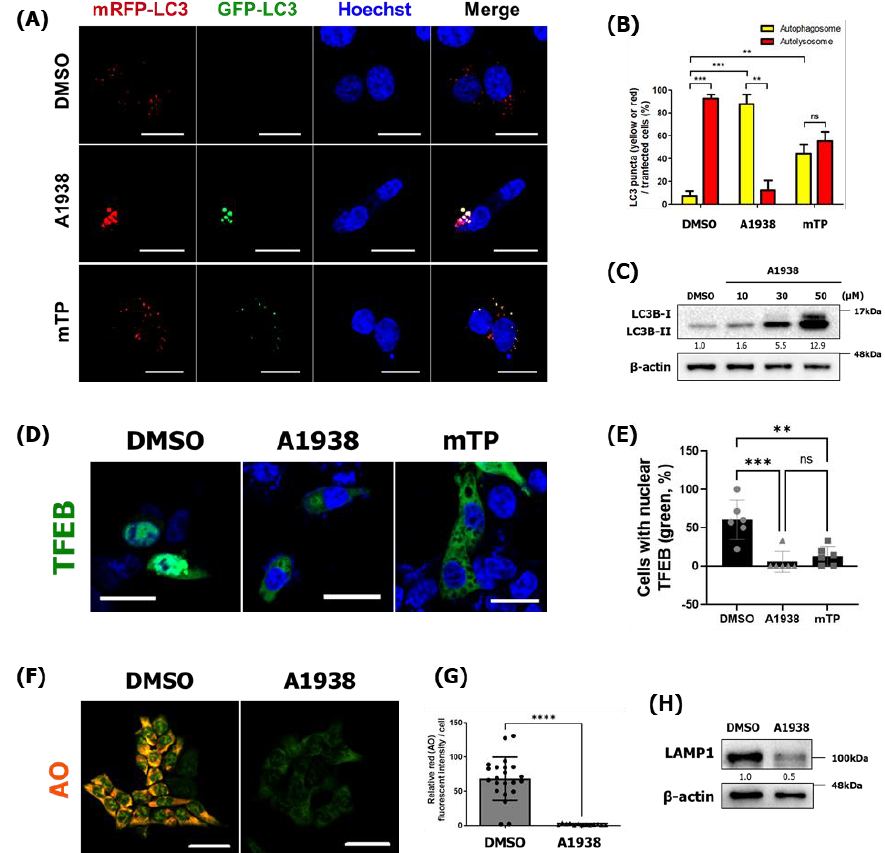
Figure 6. A1938 impairs autophagy through the downregulation of mROS in HCT116 cells ( A ) Confocal microscopy image of HCT116 cells transfected with mRFP-GFP-LC3 and treated with DMSO, A1938, or mTP for 24 h. Scale bar, 20 µ m. Quantification of data indicating red puncta (autolysosome) versus yellow puncta (autophagosome) is shown in ( B ). Values are the means ± SEM; statistical significance was assessed using a paired t -test. n = 10 cells, ns, p > 0.05, ** p < 0.01, *** p < 0.001. ( C ) HCT 116 cells treated with various concentrations of A1938 for 24 h in a serum-free medium. The resulting cell extracts were subjected to Western blot analysis using antibodies against LC3B. ( D ) Confocal microscopy images of HCT116 cells transfected with GFP-TFEB and treated with the DMSO control or A1938 for 6 h. ( E ) The number of cells with a nuclear (Nuc) or cytoplasmic (Cyt) TFEB localization ratio is represented in the graph. ( F ) HCT116 cells were treated with DMSO control or 30 µ M A1938 for 24 h. Live cells were stained with 2 µ g/mL acridine orange (AO) for 25 min, fixed, and examined by confocal fluorescence microscopy. Confocal fluorescence microscopy images of HCT116 cells treated with A1938 in RPMI medium containing 10% serum. ( G ) The average AO intensity per HCT116 cell treated with A1938 in RPMI medium containing 10% serum ( n > 10). ( H ) HCT116 cells treated with 30 µ M A1938 for 24 h and then subjected to Western blot analysis using antibodies against LAMP1. Scale bar, 20 µ m. Statistical significance was assessed using Student’s t -test. ns, p > 0.05, ** p < 0.01, *** p < 0.001, **** p < 0.0001. The relative band intensities value was normalized to β -actin (loading control). The normalized protein levels are shown under each band. All original western blots can be found at Figure